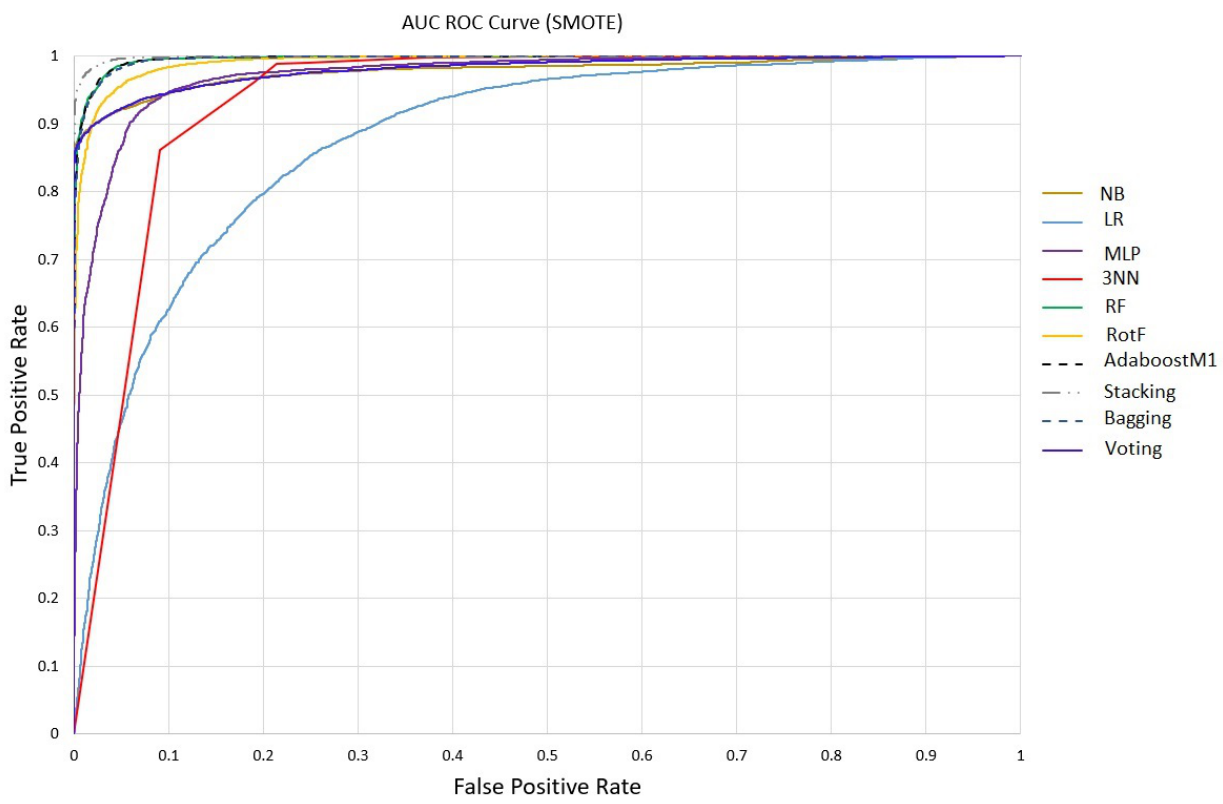
Figure 3. ML models AUC ROC curve after